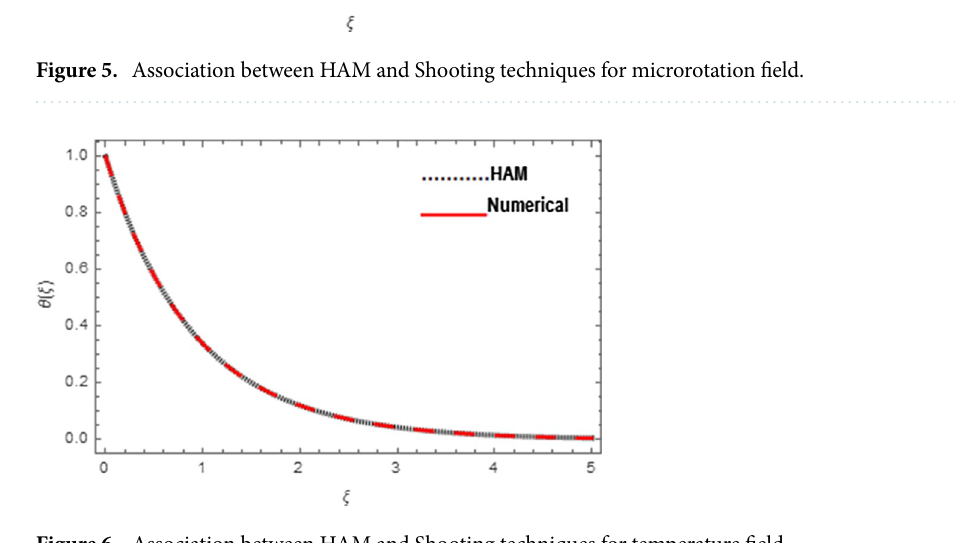
Figure 6. Association between HAM and Shooting techniques for temperature